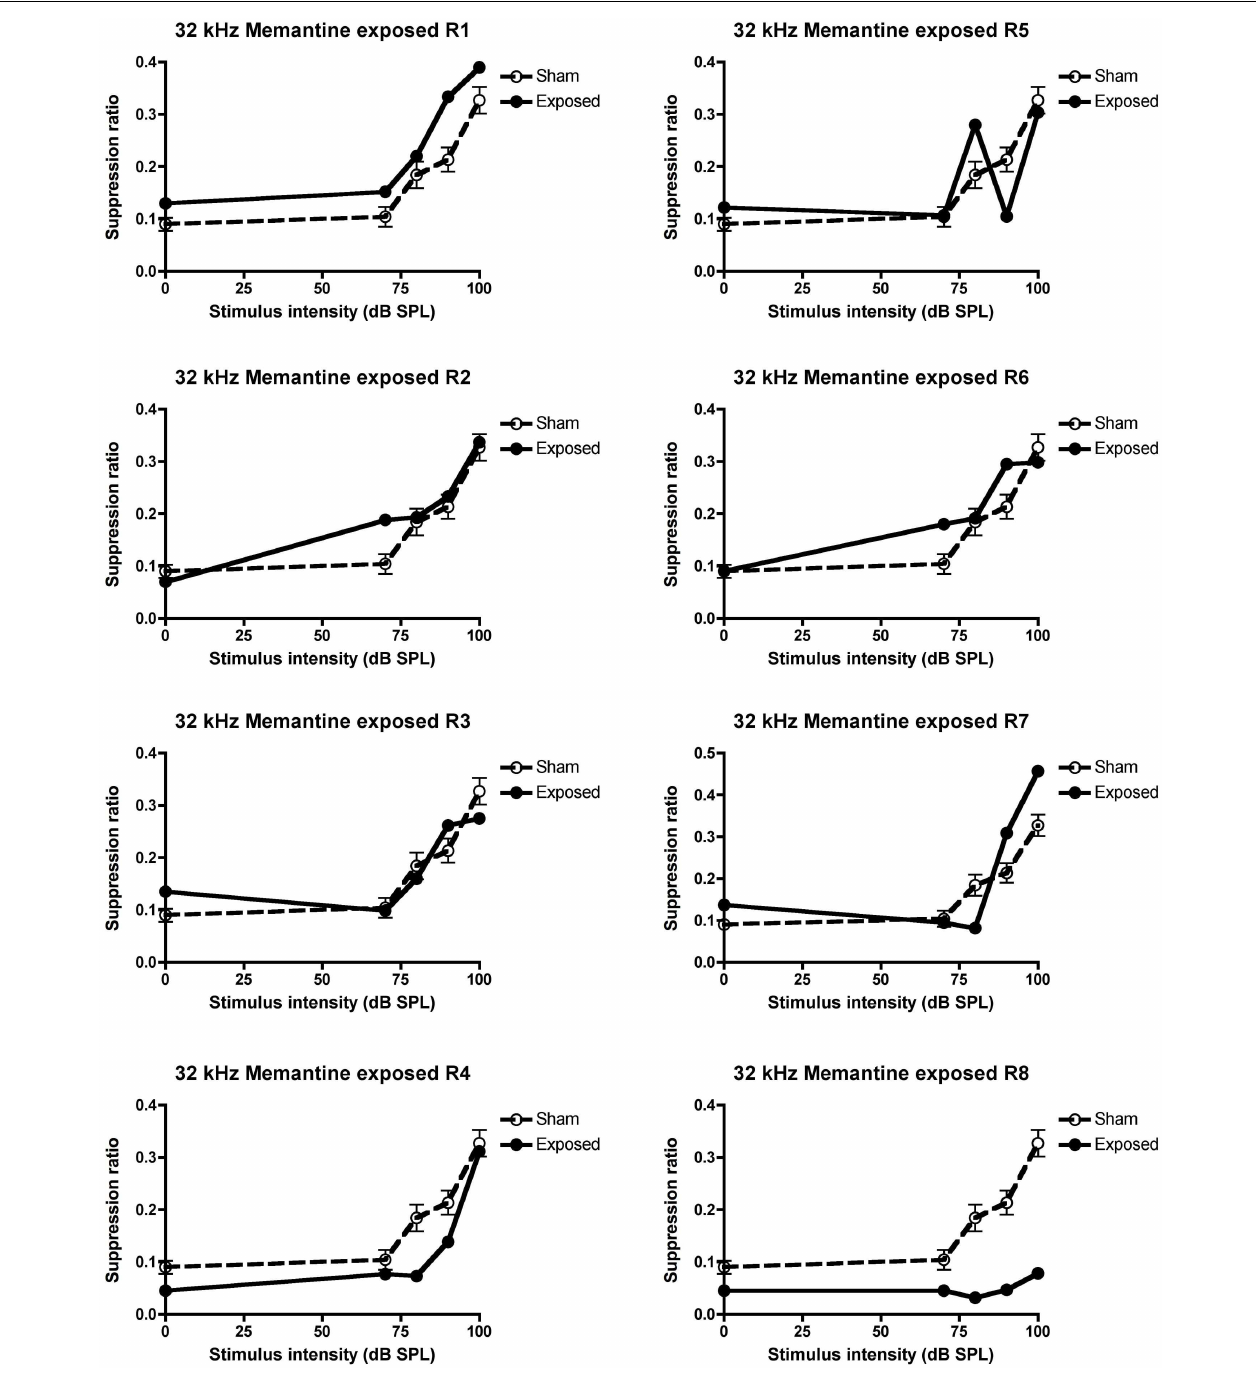
FIGURE 4 | Suppression ratios for the individual acoustic trauma-exposed animals plotted against the mean SRs of the sham control animals following the 5mg/kg s.c. memantine administration, as